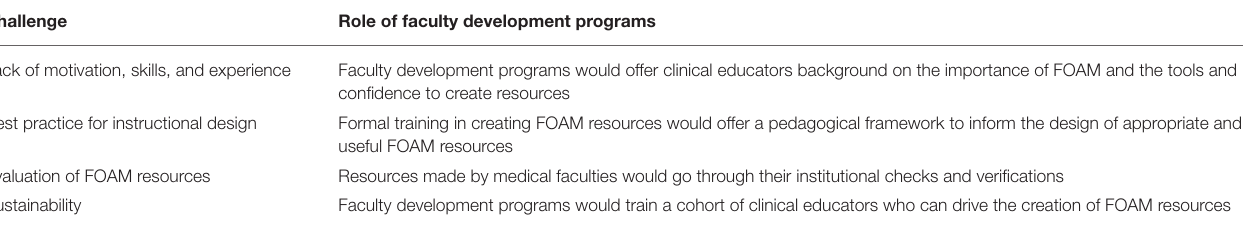
TABLE 1 | The challenges in the implementation of free, open access medical resources, and the role of faculty development programs in addressing them.